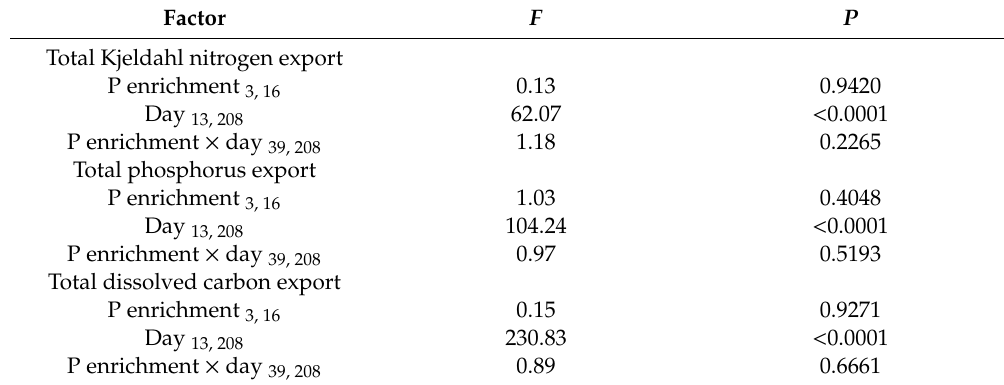
Table 4. E ff ects of P enrichment and day on vegetated mesocosm TKN, TP and TDOC export during winter storm events. F values and associated P values are based on linear mixed-e ff ect models that incorporated random e ff ects to account for repeated measures within each